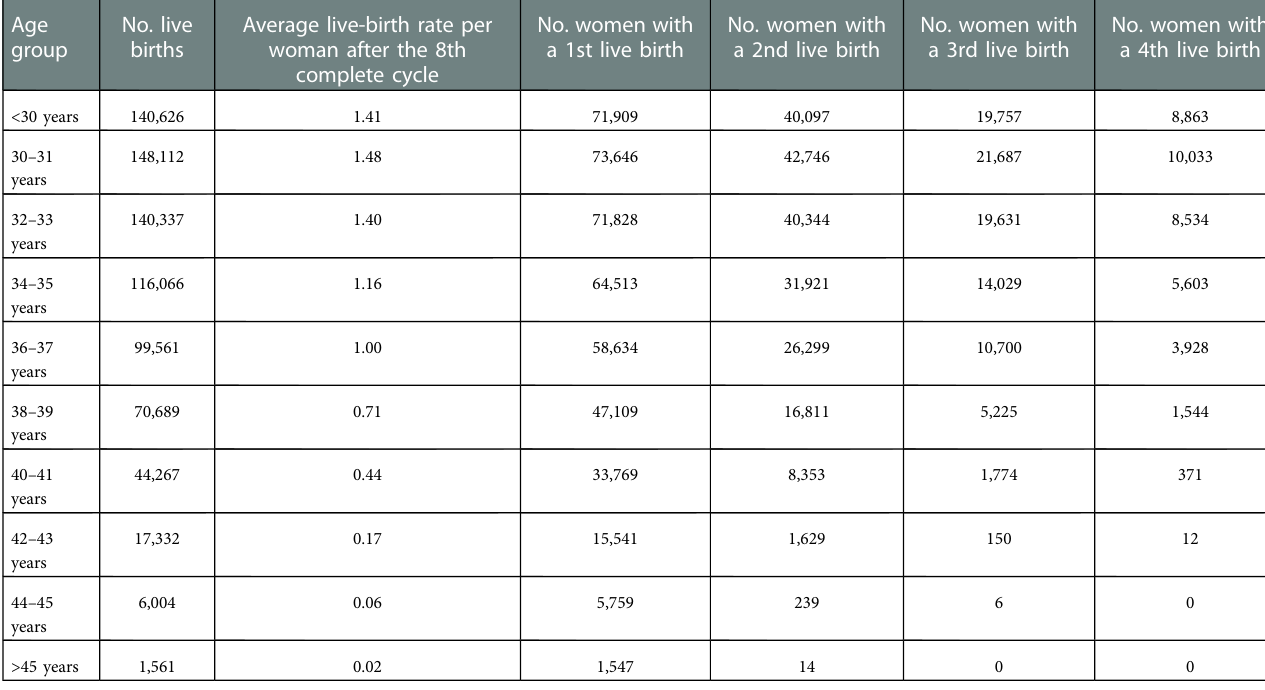
Average live-birth rate per woman after the 8th complete cycle is calculated as the number of live births divided by the number of women per age group simulated in the Markov model ( n =100,000). No., number.